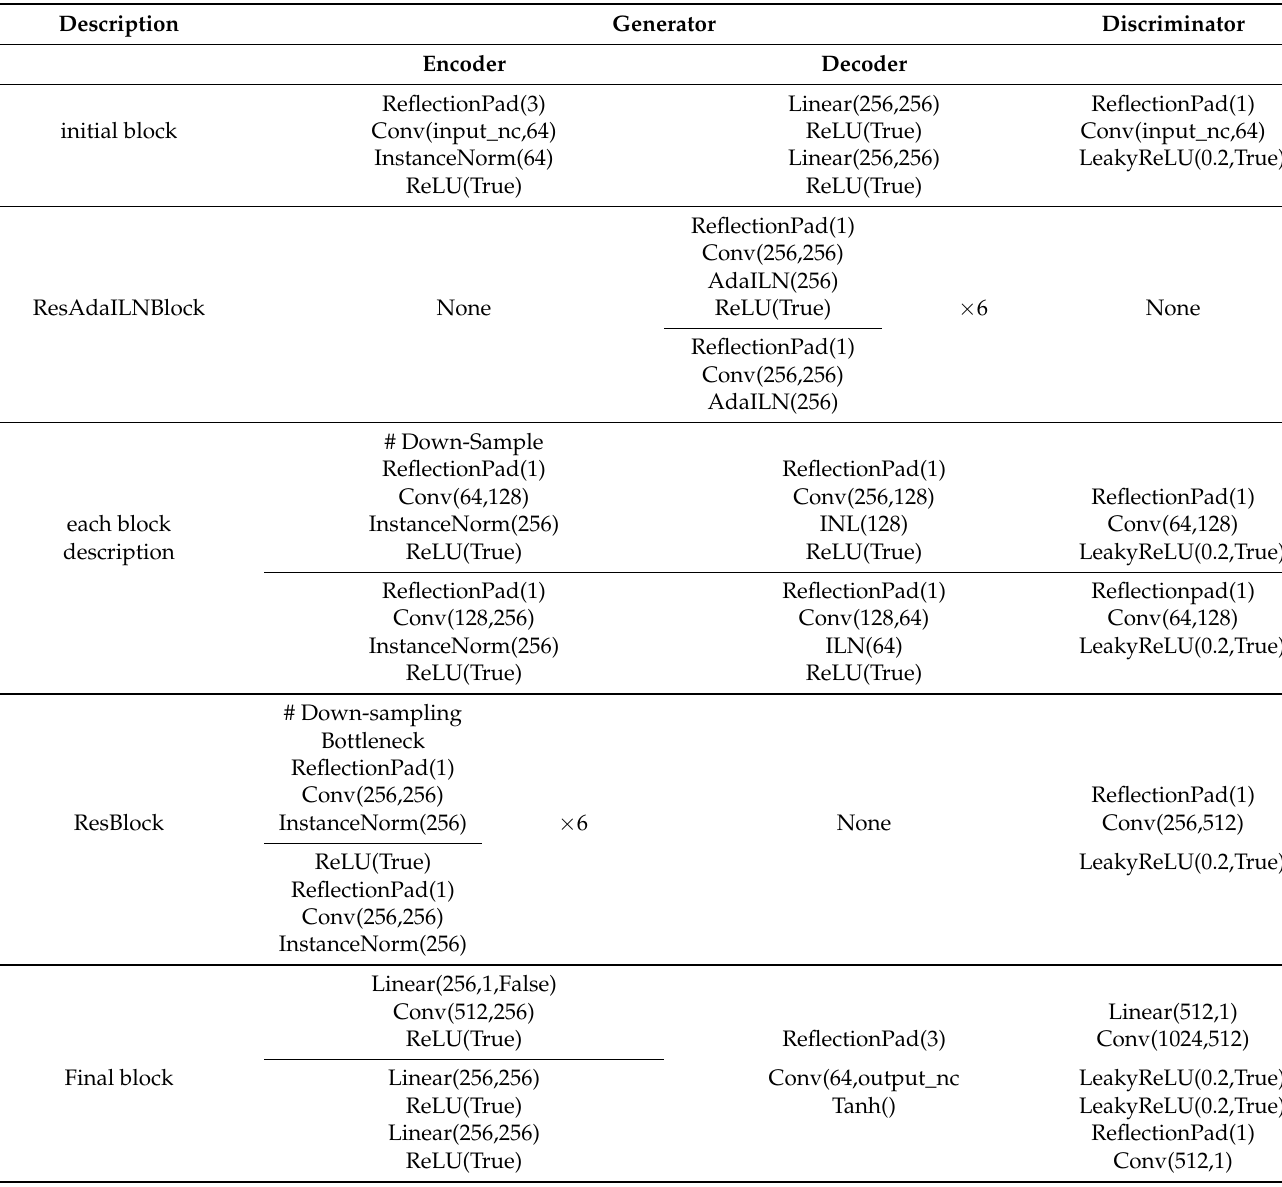
Table 1. The layers of generator and